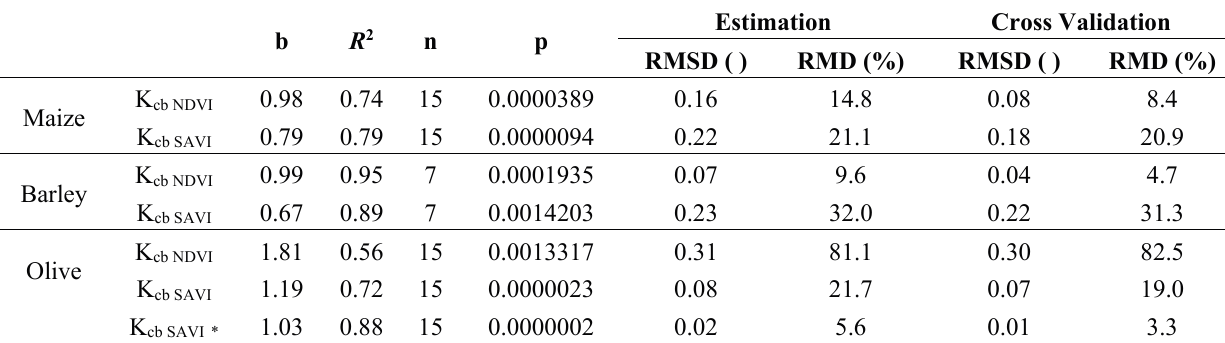
Table 5. Statistical indicators relative to the comparison between K cb VI and K cb SIMDualKc for maize and barley when f c VI computed with NDVI and for olive crops when f c VI is computed with NDVI and SAVI *.